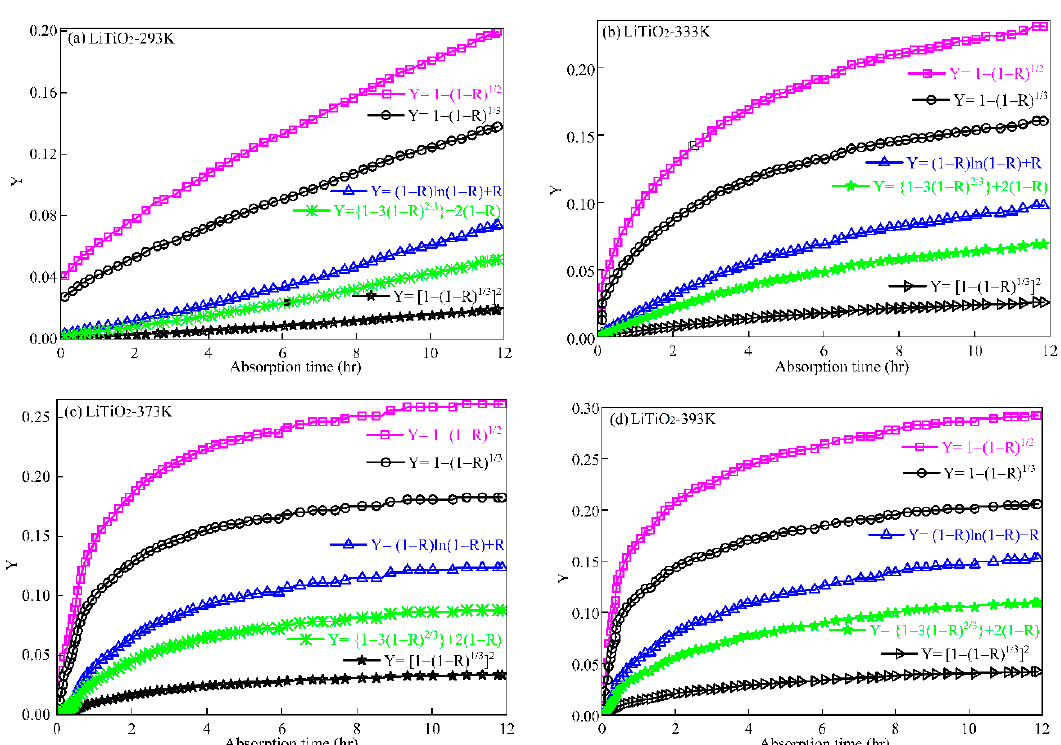
Figure 9. Plot of reaction kinetics and absorption time at 293 K ( a ), 333 K ( b ), 373 K ( c ), and 393 K ( d ) for data from Figure 4.